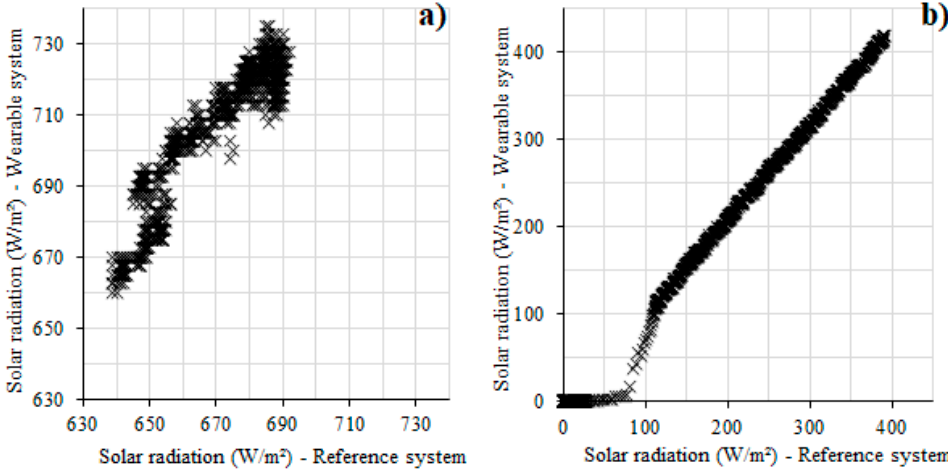
Figure 7. Comparison between the developed wearable system and the reference system (compact weather station) for solar radiation: ( a ) monitoring during midday; ( b ) monitoring at sunset.